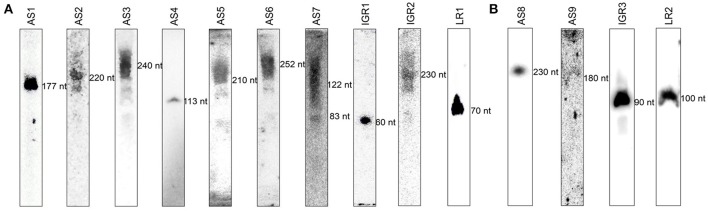
Detection of novel and established sRNAs by RNA blot hybridization. Fifty micrograms of total RNA was loaded per lane on a 10% polyacrylamide gel that was electro-blotted on Hybond-N nylon membranes. All sRNAs were detected with an oligonucleotide probe in the differential expression library (A) and unique sRNA library under NL conditions (B).